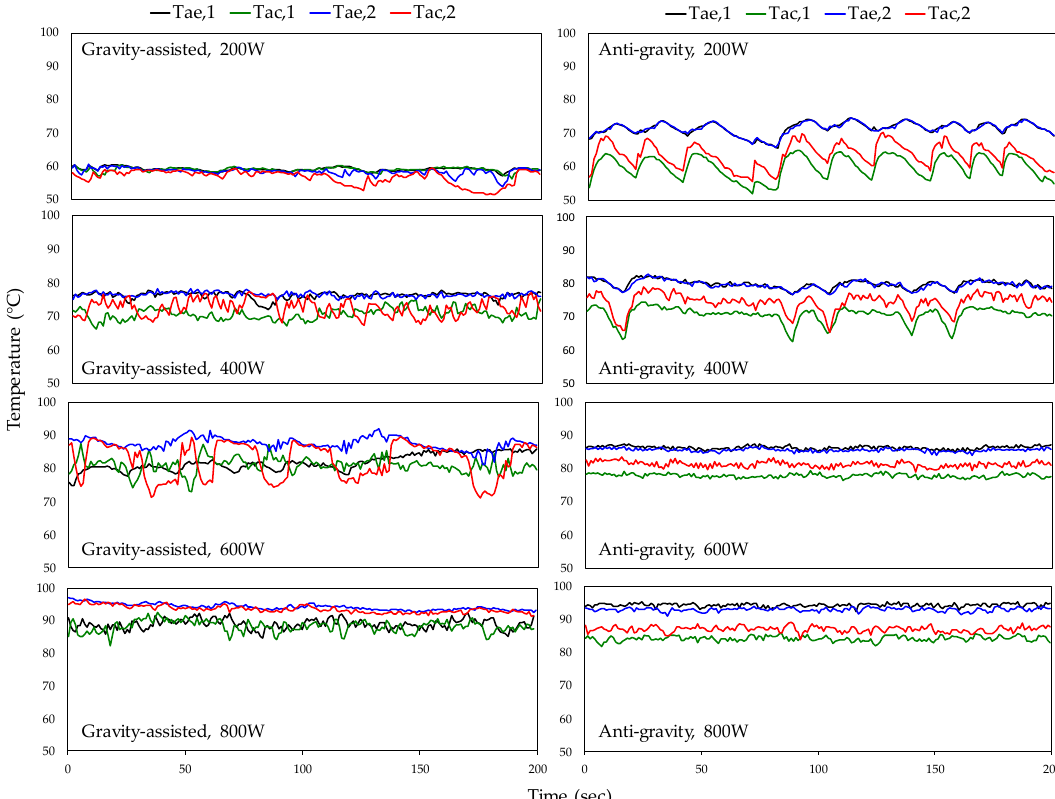
Figure 10. Adiabatic section temperature variation for proposed 3D-PHP.